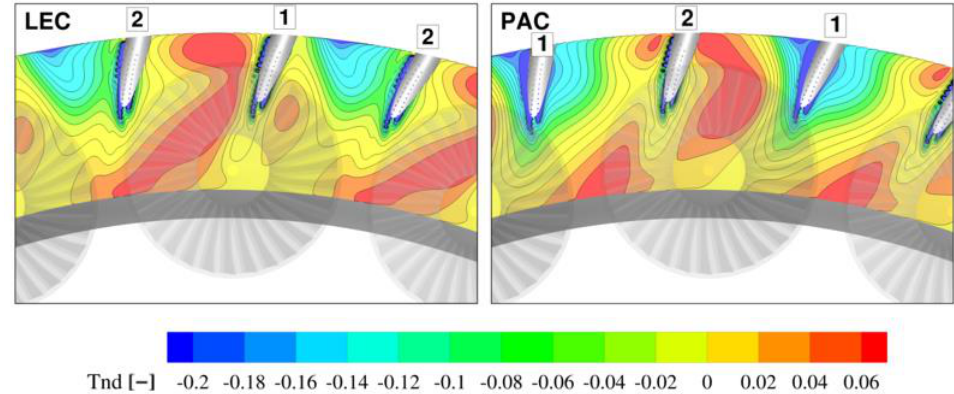
Figure 13. Non-dimensional temperature at the LE plane.